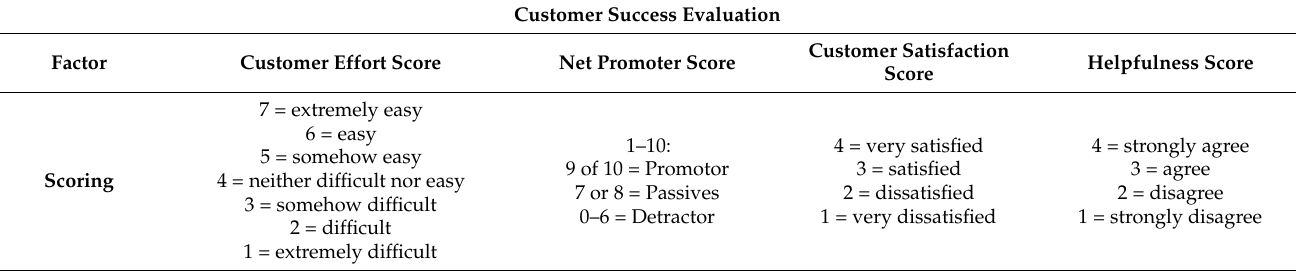
Table 2. Factors and scoring of Customer Success